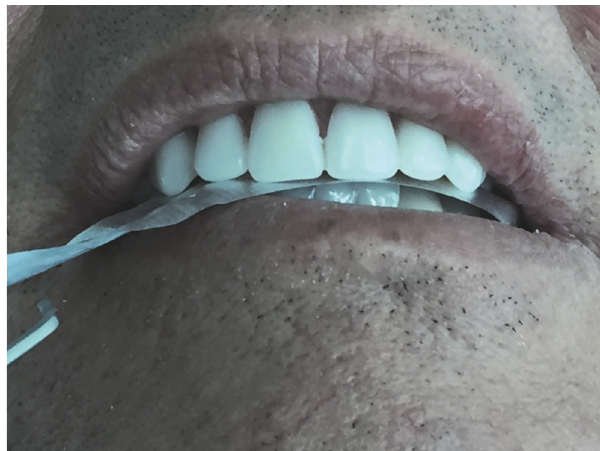
Figure 1: Metal foil placed between the upper and lower incisor